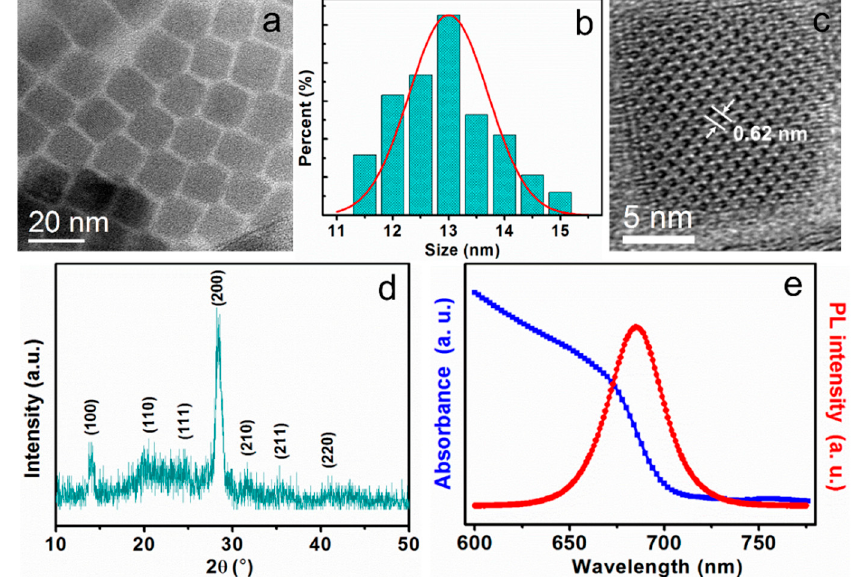
Figure 1. ( a ) TEM image of monodisperse CsPbI 3 quantum dots (QDs); ( b ) Histogram for the size distribution of the CsPbI 3 QDs; ( c ) High-resolution TEM (HRTEM) image of monodisperse CsPbI 3 QDs; ( d ) The XRD spectrum of CsPbI 3 QDs; ( e ) UV-vis absorption and photoluminescence (PL) spectra (with 325 nm excitation wavelength) of CsPbI 3 QDs.